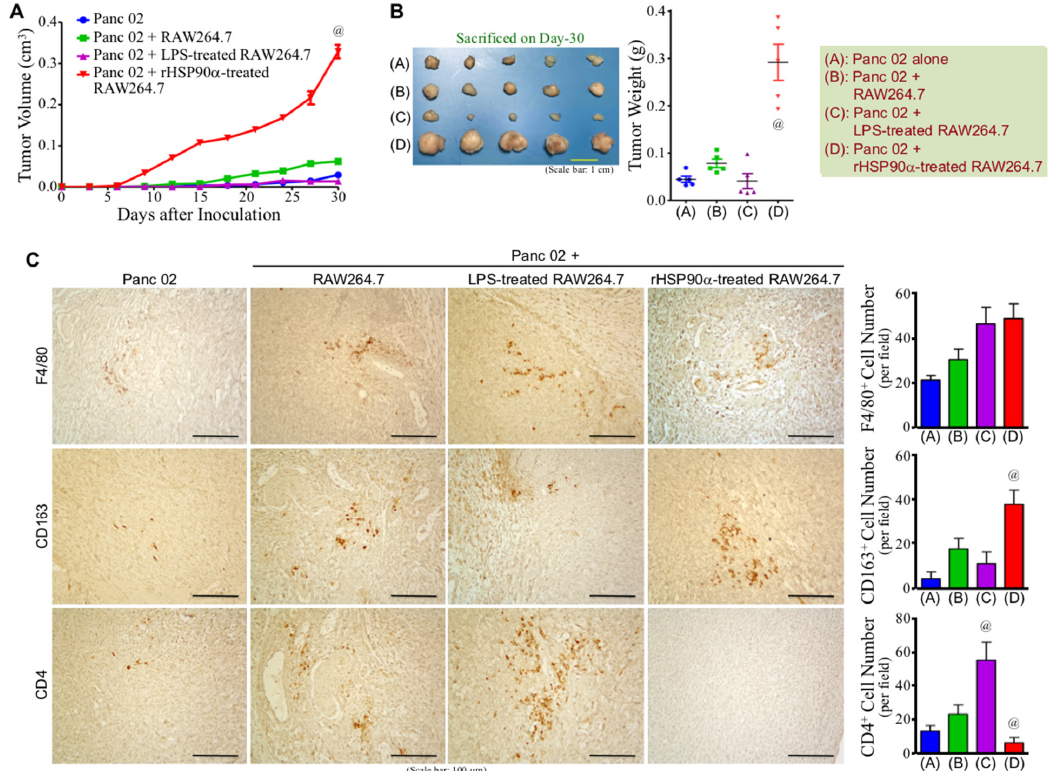
Figure 5. eHSP90 α -induced M2-polarized macrophages exhibit significant tumor-promoting activ- ity. ( A , B ) Promotion of the tumor growth of Panc 02 cell grafts by rHSP90 α -treated macrophages. C57BL/6 mice were subcutaneously injected with Panc 02 cells alone or together with the RAW264.7 cells pretreated for 24 h with 100 ng/mL of LPS or 15 μ g/mL of rHSP90 α ( n = 5 per group). The sizes of developing tumors were superficially measured using a Vernier caliper and their volumes were calculated with the formula of ½ × length × width 2 ( A ). Mice were sacrificed on day 30 post- inoculation and tumors were removed ( B ). @ p < 0.01 when compared with “Panc 02” or “Panc 02 + RAW264.7”. ( C ) IHC of F4/80, CD163, and CD4 from the tumors formed by Panc 02 cells alone (designated as “Panc 02” group) or Panc 02 cells mixed with PBS-, LPS-, or rHSP90 α -treated RAW264.7 cells (designated as “Panc 02 + RAW264.7”, “Panc 02 + LPS-treated RAW264.7”, and “Panc 02 + rHSP90 α -treated RAW264.7” groups, respectively). Quantification of IHC was performed by counting positively stained cells from 3~5 high power fields of each tissue section. @ p < 0.05 when compared with “Panc 02” or “Panc 02 + RAW264.7”